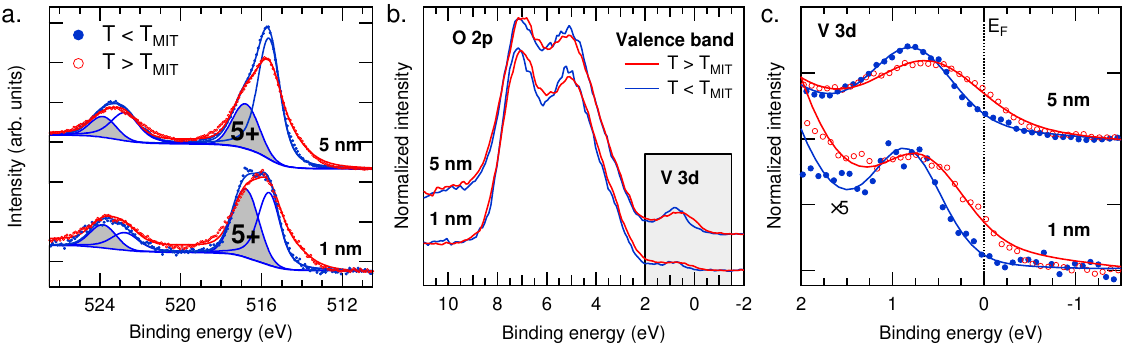
Figure 6. ( a ) V 2p HAXPES measured above (red) and below (blue) T (100) films with thickness of 5 nm and 1 nm, respectively. Peak fitting results are shown for the low temperature measurement; ( b ) Valence band HAXPES; and ( c ) an expanded view of the topmost V 3d states of the same two